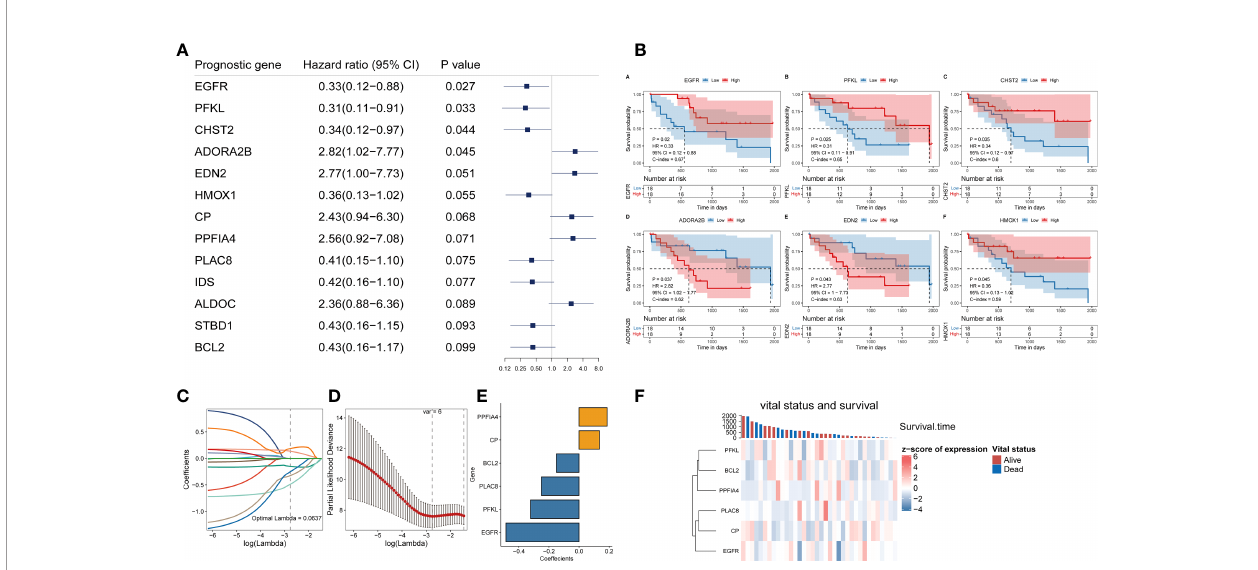
FIGURE 1 | Construction of a hypoxia-related prognostic model for CHOL. (A) A forest map showed 13 hypoxia-related signatures identi fi ed by univariate Cox proportional hazard regression. (B) OS curves of CHOL patients with different PPFIA4 expression. (C, D) The LASSO Cox regression model to identify the most robust hypoxia-related signatures. (E) Distribution of LASSO coef fi cients of the hypoxia-related gene signature. (F) The heatmap of the vital status, survival and gene